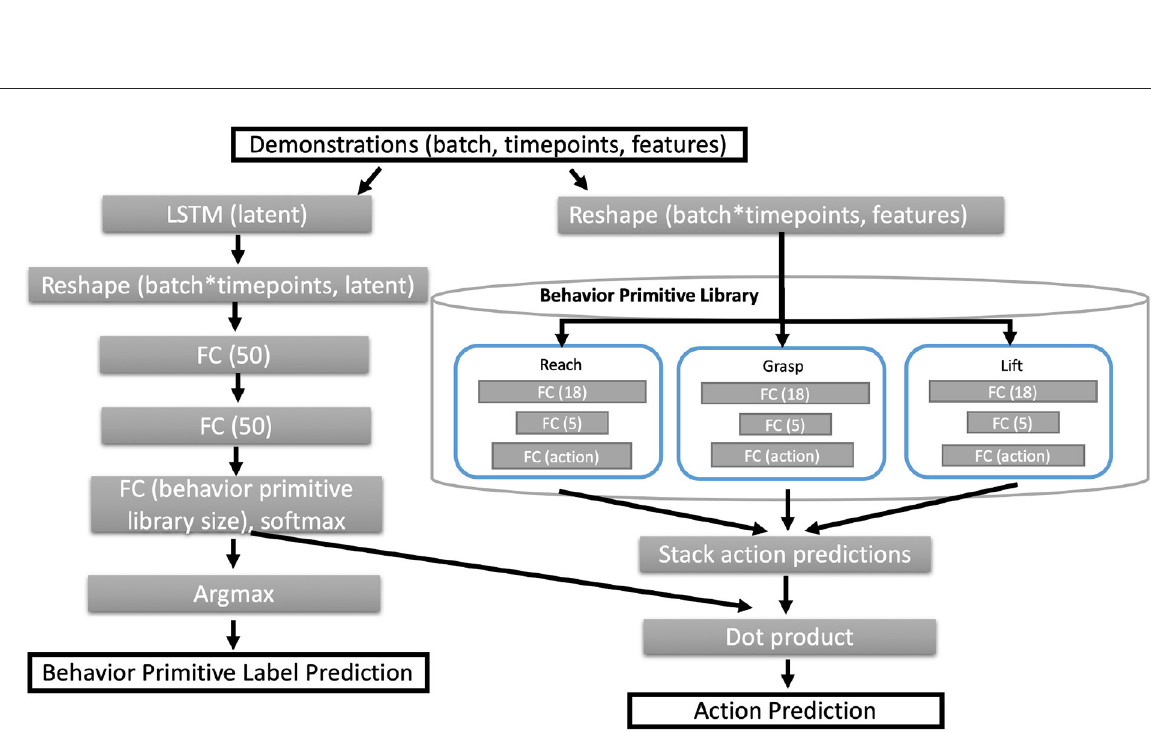
FIGURE4 Neural network architecture for PICO . Given a set of input trajectories and a behavior primitive library, the core architecture follows two branches, the left most branch estimates a distribution over the behavior primitives. The right hand branch estimates the action prediction from each primitive behavior sub-model. We compute the predicted action as a linear combination between the behavior primitive distribution and the set of predicted actions from all behavior